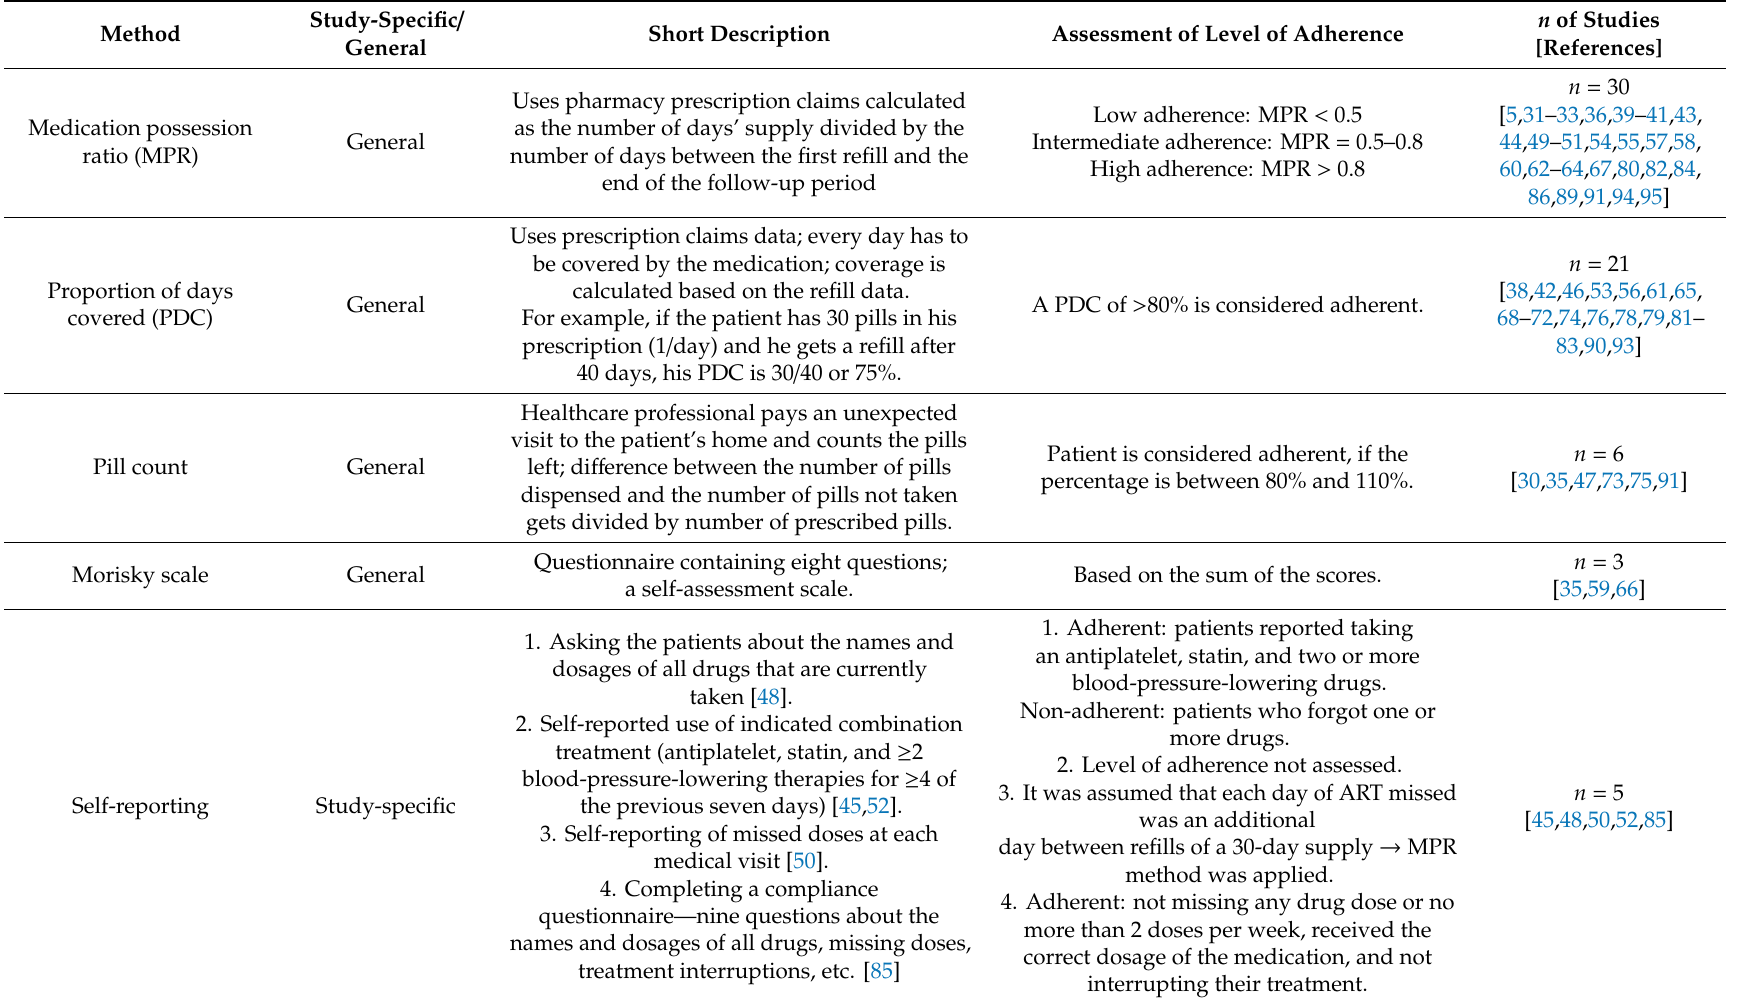
Table 4. Methods for measuring adherence applied in the articles ( n =